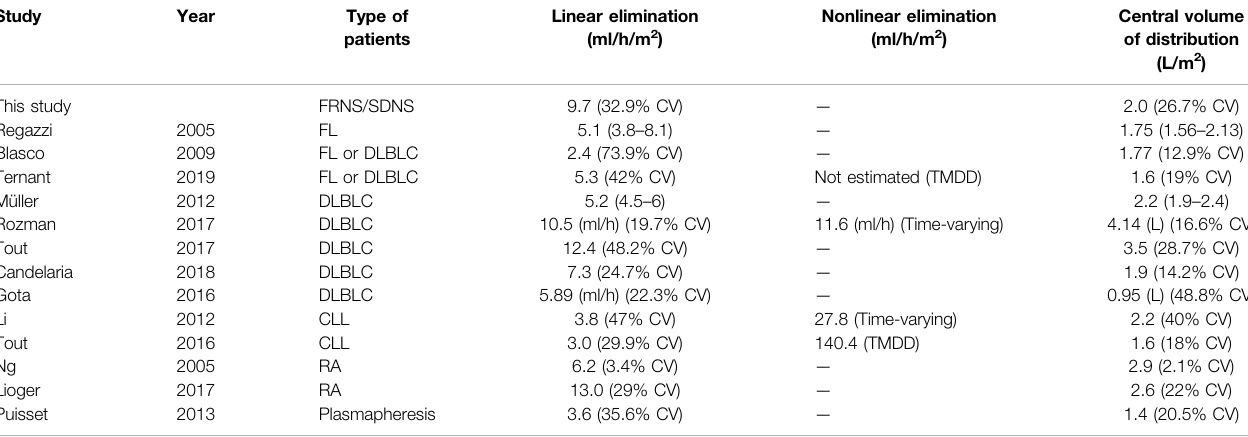
TABLE 3 | Exposure parameters of rituximab in population pharmacokinetic studies.